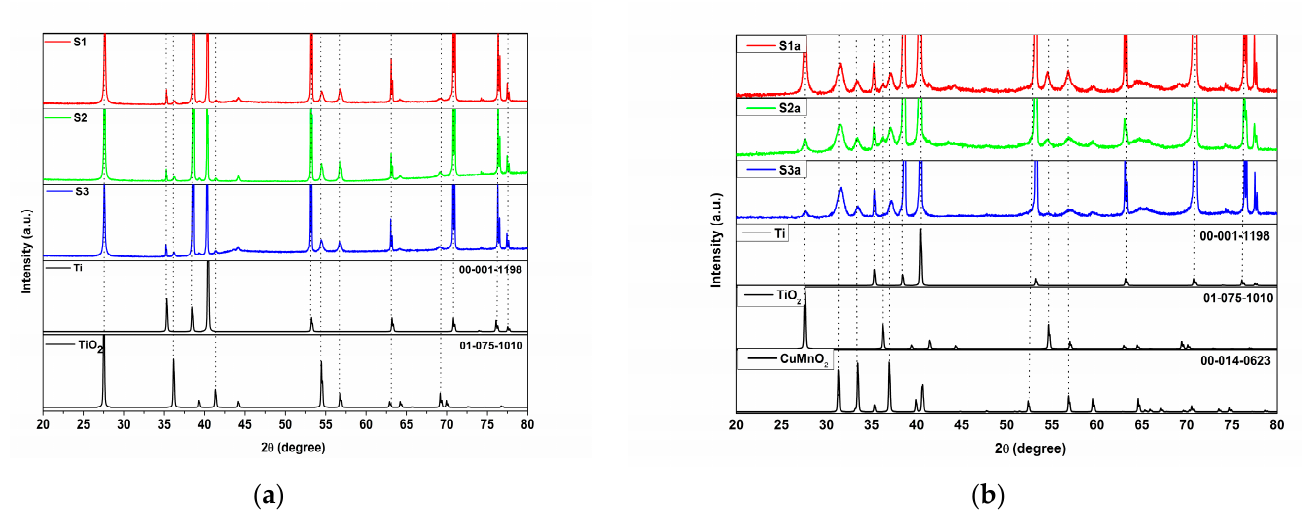
Figure 2. X-ray patterns for ( a ) Ti-TiO 2 layers and ( b ) as-synthesized Ti-TiO 2 -CuMnO 2 heterostructures.